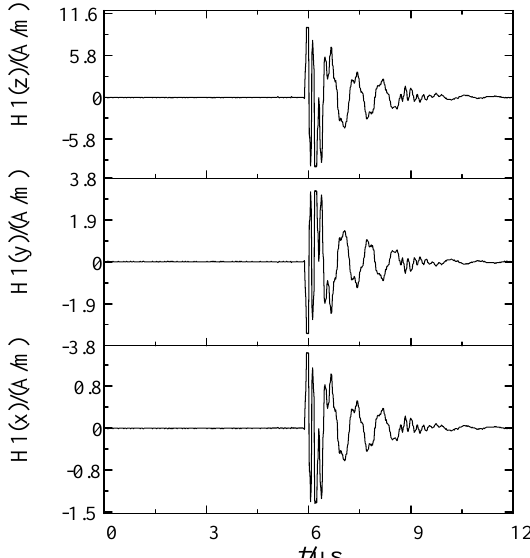
Figure 10. Simulation of the three-dimensional magnetic field waveform of B-phase sensor side (1 mm).